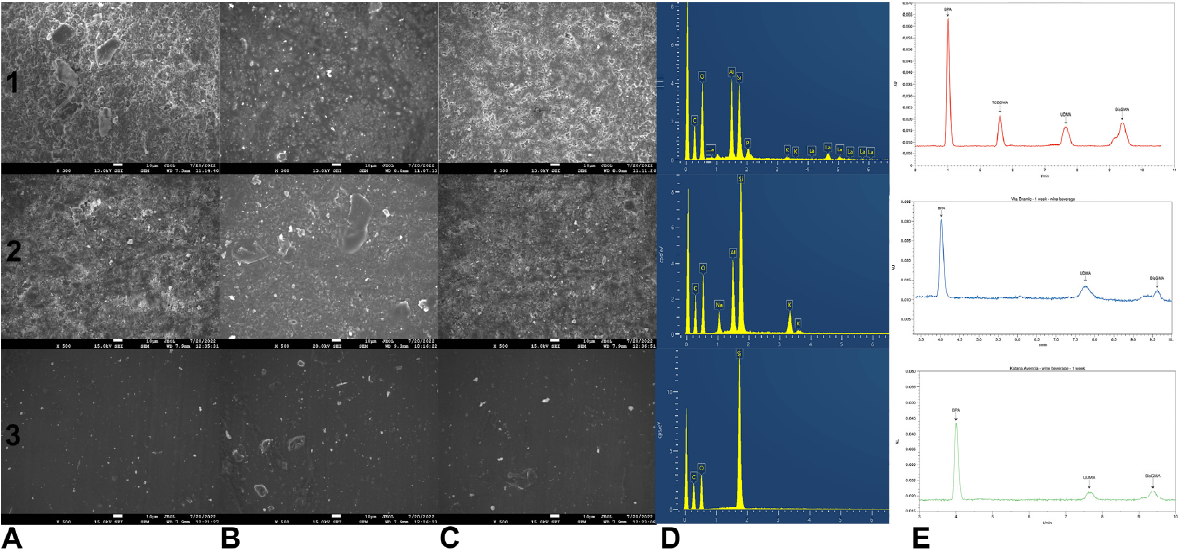
Figure 2. Scanning electron microscope (SEM) images of ( 1 ) Resin composite, ( 2 ) Vita Enamic, ( 3 ) Katana Avencia specimens that were immersed in ( A ) wine, ( B ) cola, ( C ) coffee solution (original magnification Å~1000). ( D ) Energy-dispersive X-ray spectroscopy (EDS) profiles for the elemental composition, ( E ) representative high-performance liquid chromatograms of resin composite material after 1 week of immersion in wine. Chromatographic conditions are described in text.